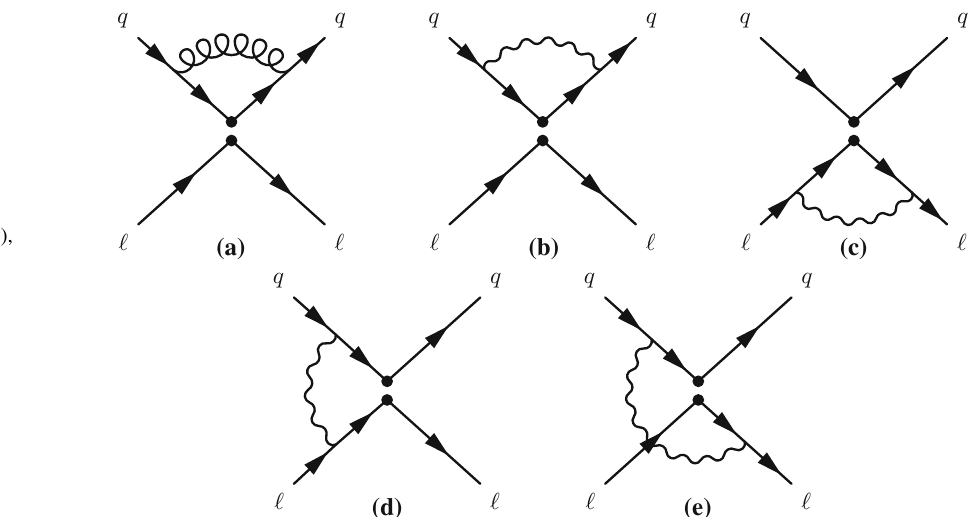
Fig. 2 One-loop QCD and QED corrections to the quark-lepton LFV effective operators. The contribution of the QCD-vertex correction in diagram ( a ) is shown in Eq. (20), while the one-loop QED corrections in diagrams ( b ), ( c ), ( d ), and ( e ) are shown in Eqs. (21), (22), (23), and (24),